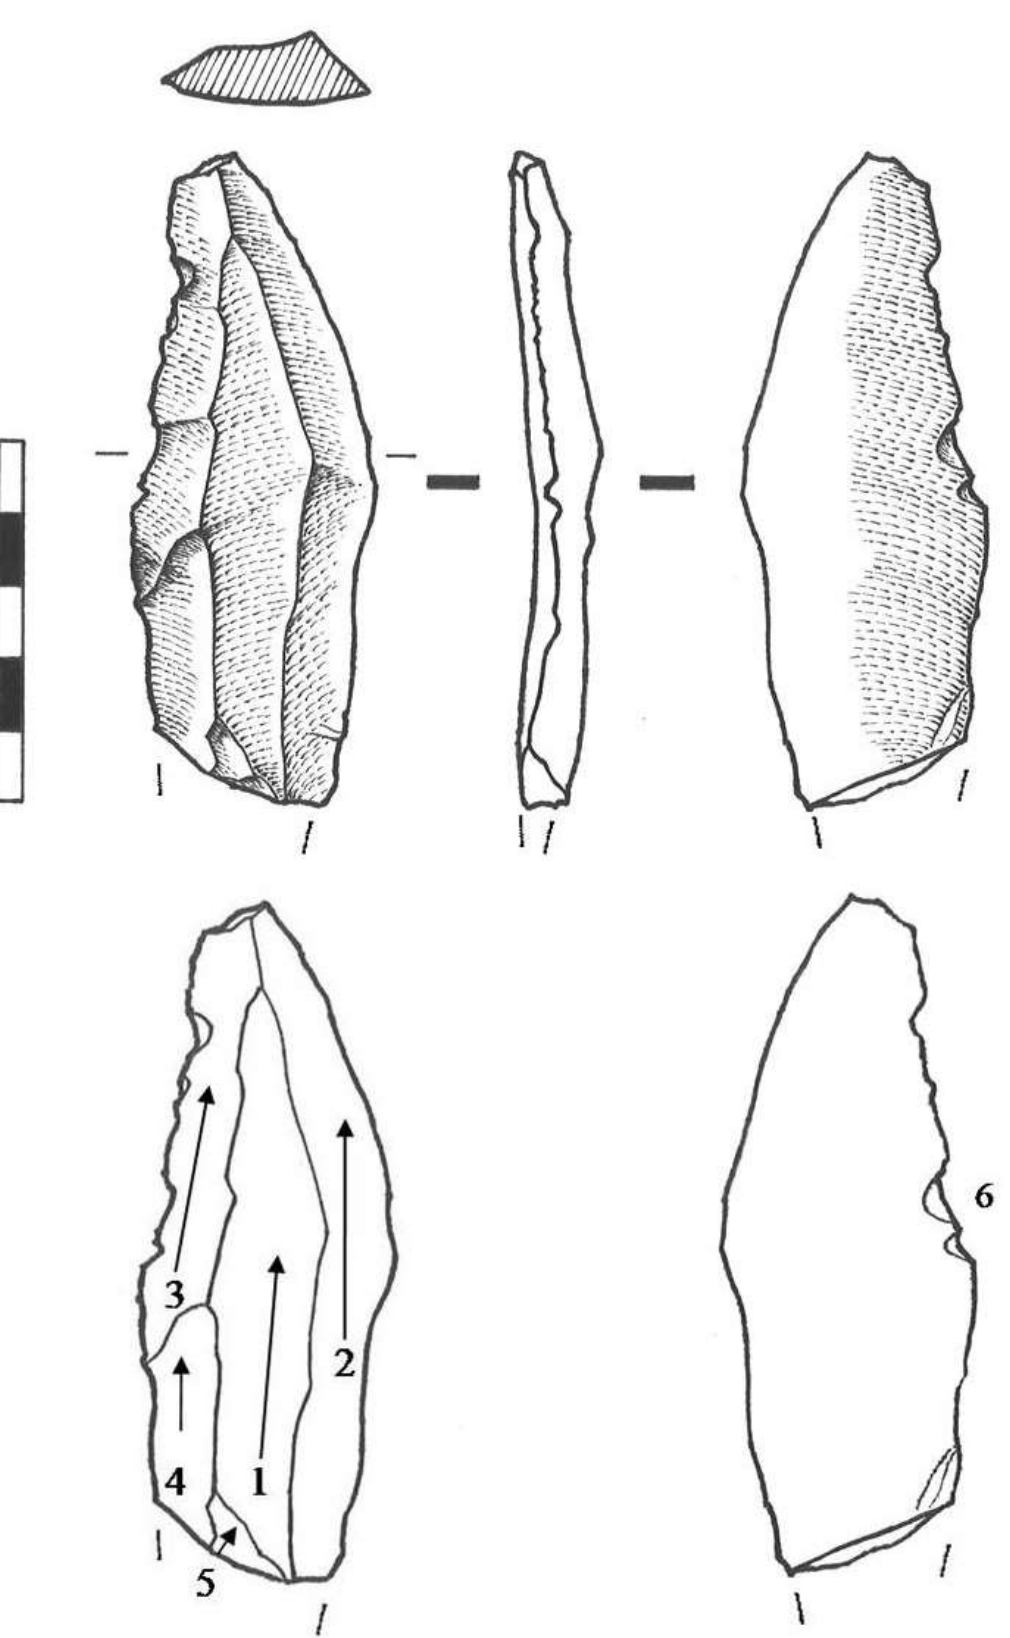
Figure 5. Technological drawing (superior) and diacritic scheme (inferior) of blade PCO023. Arrows indicate interpreted direction of flaking and numbers indicate the order of